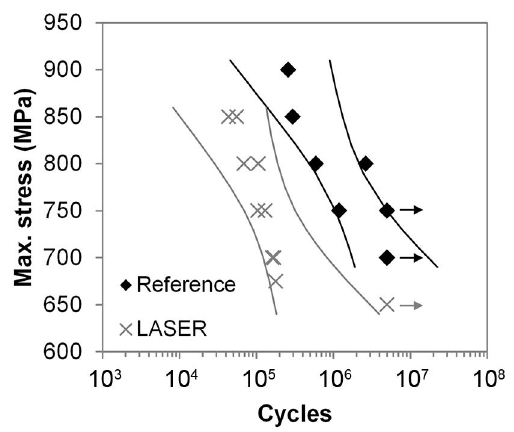
Figure 8. S-N curves for the untreated (reference) and laser-treated conditions. The results of surface roughness of modified and reference samples are presented in Table 1. There is a difference in the results obtained with the techniques, although the standard deviation values indicate that such difference is not significant.